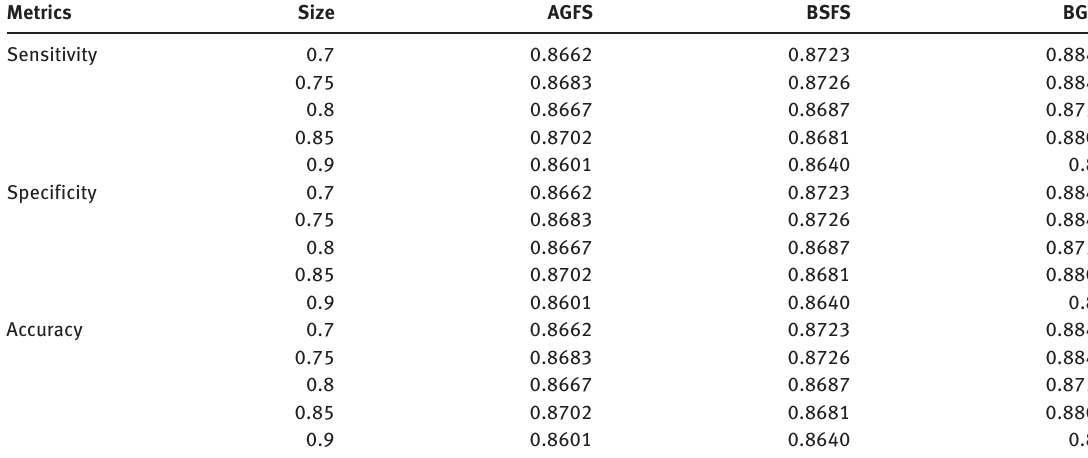
Table 5: Comparison on DRD.